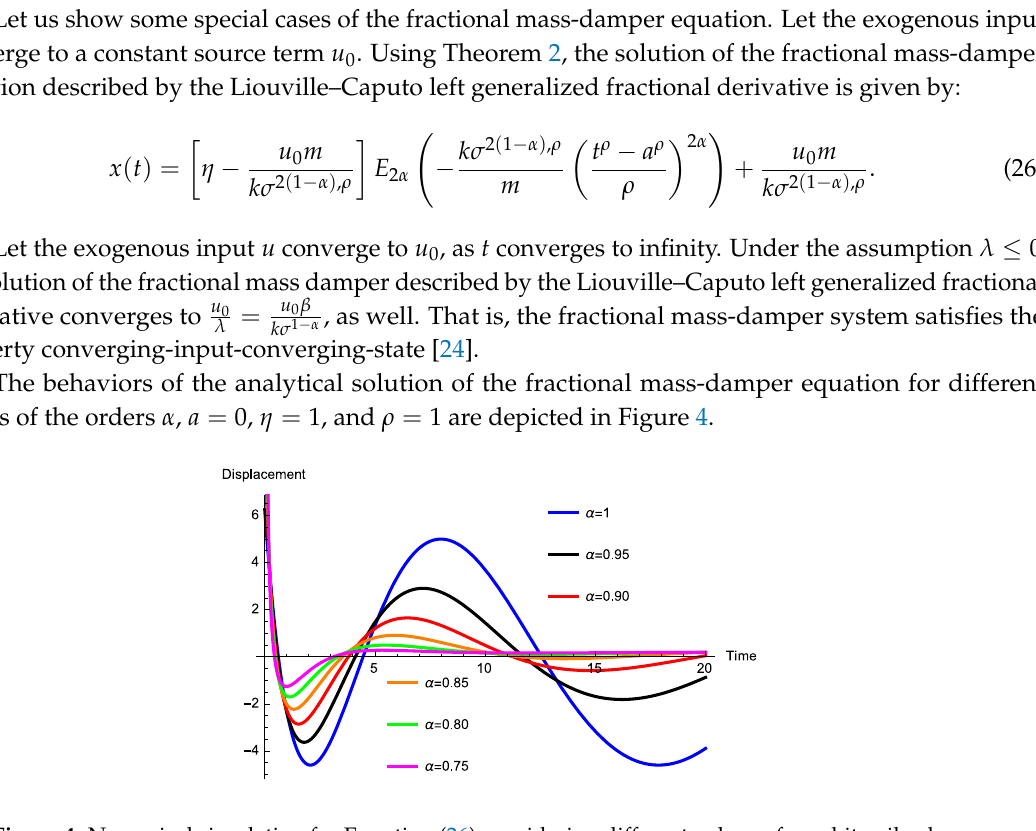
Figure 4. Numerical simulation for Equation (26) considering different values of α , arbitrarily